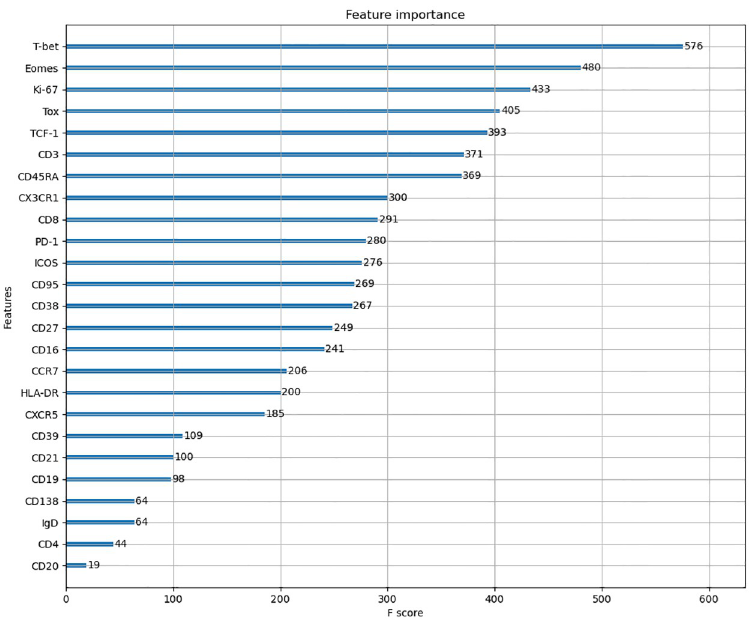
Fig 4. Rank ordering of proteins using a decision tree based classifier. Shows rank ordering of proteins by descending values of feature importance generated by the classifier XBoost.